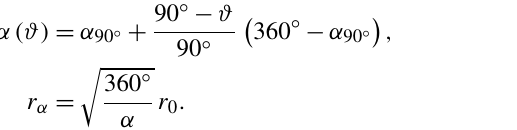
Figure 2. Average surface albedo from the non-scattering retrieval (Schneider et al., 2020a) of the year 2018, which is used as a priori surface albedo for the scattering retrieval. Values over oceans and lakes (where the non-scattering retrieval does not yield data) are set to 0. Table 1. Quality filters and selection criteria for clear-sky and cloudy-sky